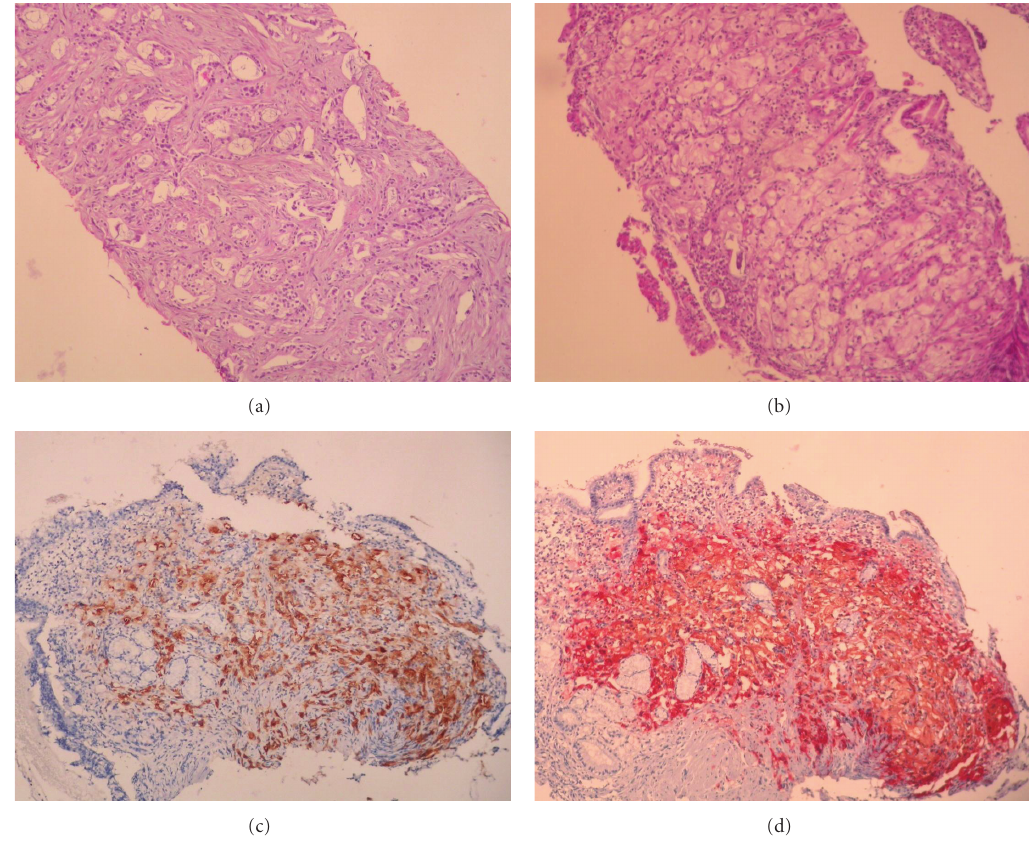
Figure 1: (a) Prostatic needle core biopsies show Gleason’s grade 4 prostatic adenocarcinoma. (hematoxylin-eosin stain, × 200). (b) The gastric biopsy reveals infiltration of the neoplastic cells with round nuclei and abundant eosinophilic to amphophilic cytoplasm. (hematoxylin-eosin stain, × 200). (c) The neoplastic cells strongly immunoreactive for PSA (Immunohistochemical stain for PSA, × 200). (d) The neoplastic cells strongly immunoreactive for PSAP (immunohistochemical stain for PSAP, × 200).